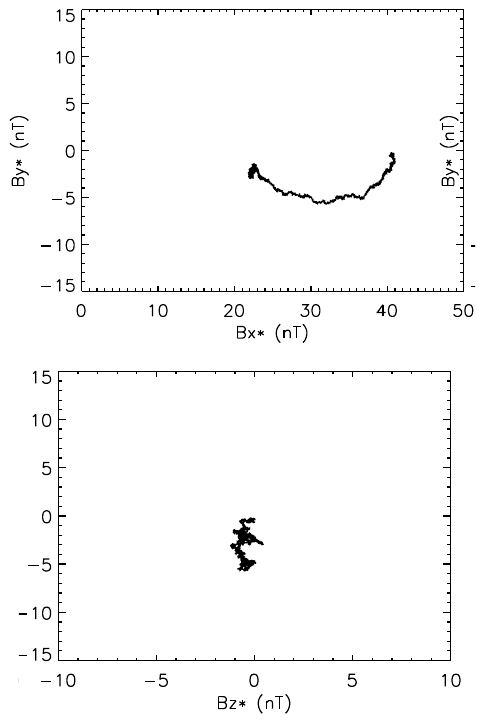
Fig. 6. Magnetic field rotation in the plane of maximum variance and in the plane of minimum variance during an SI event observed on 17 August